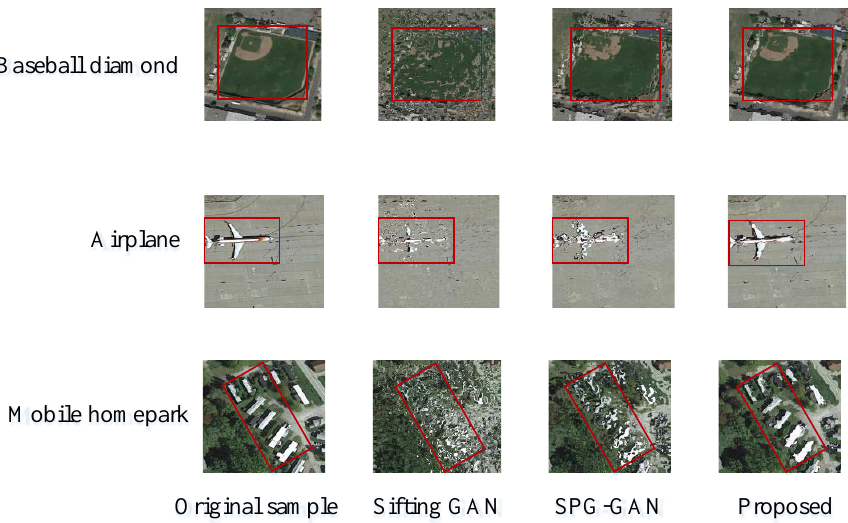
Figure 6. Comparison of samples generated by our approach and other approaches on the UC Merced dataset.